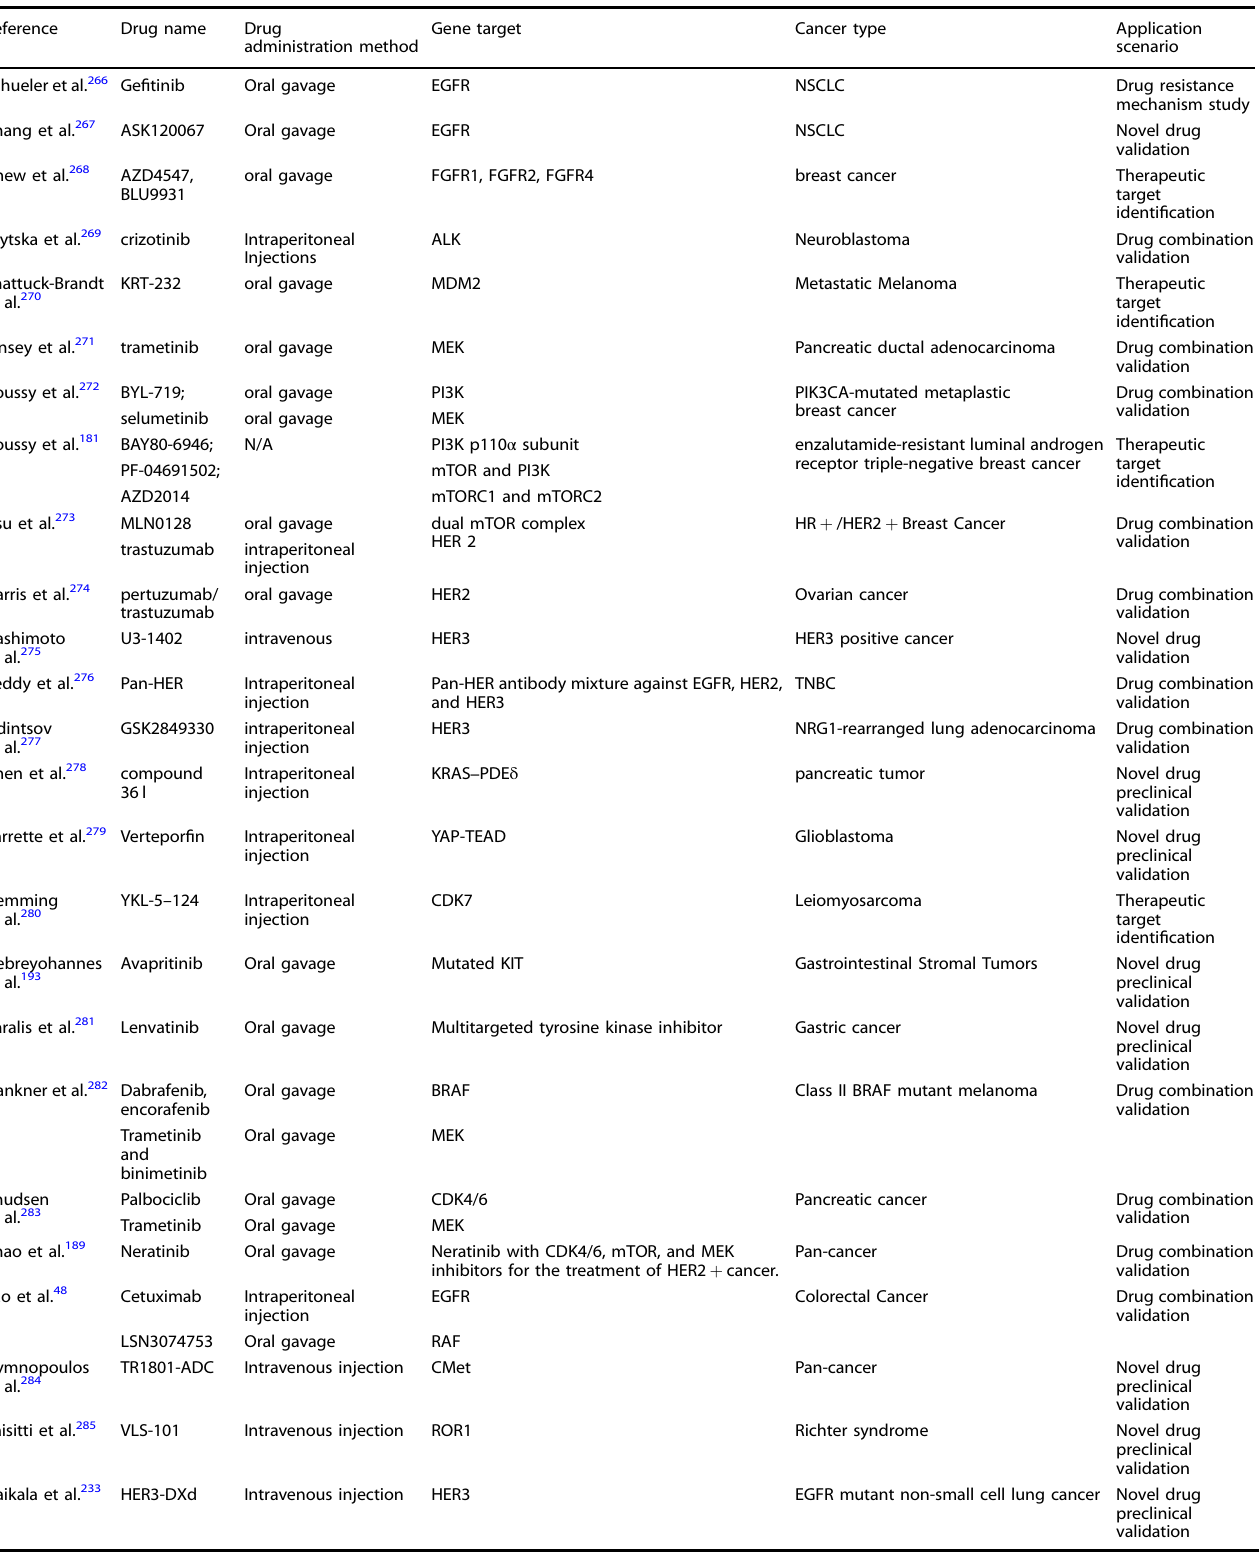
Table 4. PDX model in targeted therapy research